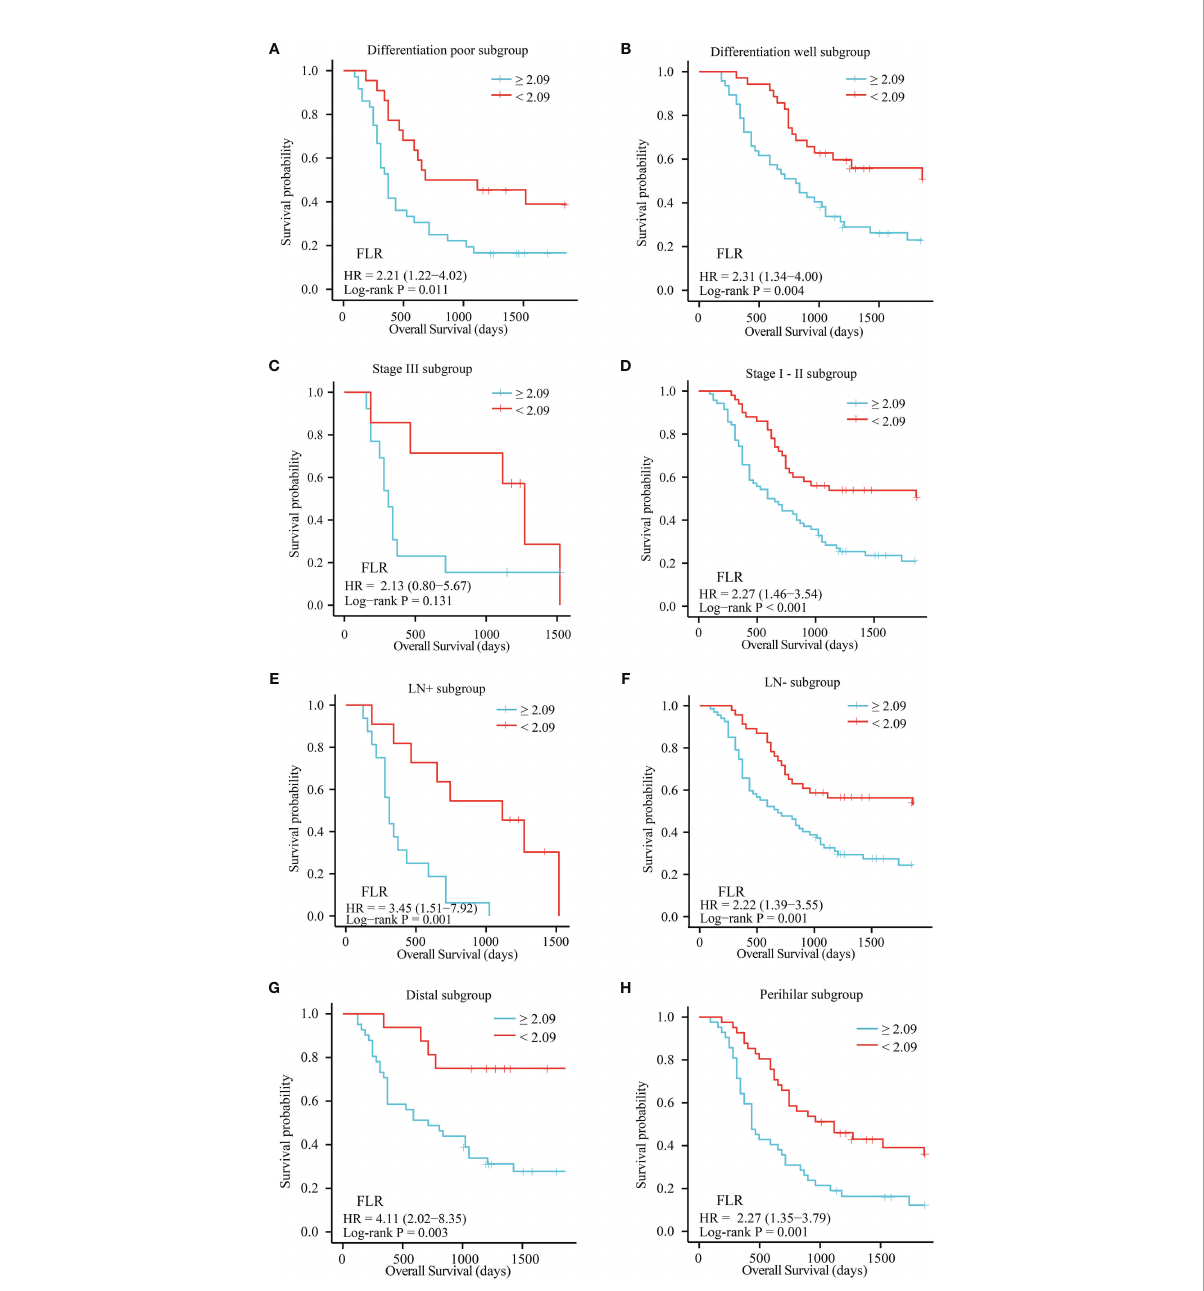
FIGURE 3 OS of patients with resectable ECC based on the optimal cutoff value of FLR in each subgroup. (A) Differentiation poor subgroup; (B) Differentiation well subgroup; (C) Stage III subgroup; (D) Stage I-II subgroup; (E) LN+ subgroup; (F) LN- subgroup; (G) Distal subgroup; (H) Perihilar subgroup. OS, overall survival; FLR, fi brinogen-to-lymphocyte ratio; LN-, lymph node metastasis negative; LN+, lymph node metastasis